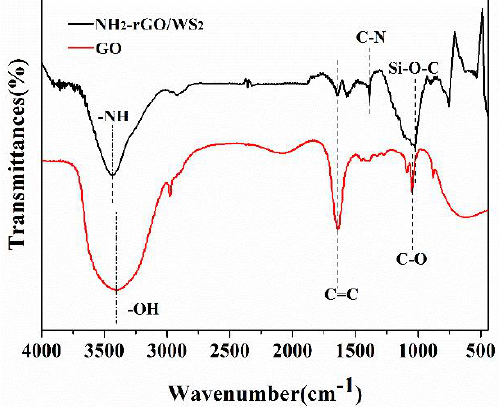
Figure 1. FT-IR spectra of as-prepared GO and NH 2 -rGO/WS 2 nanoparticles.